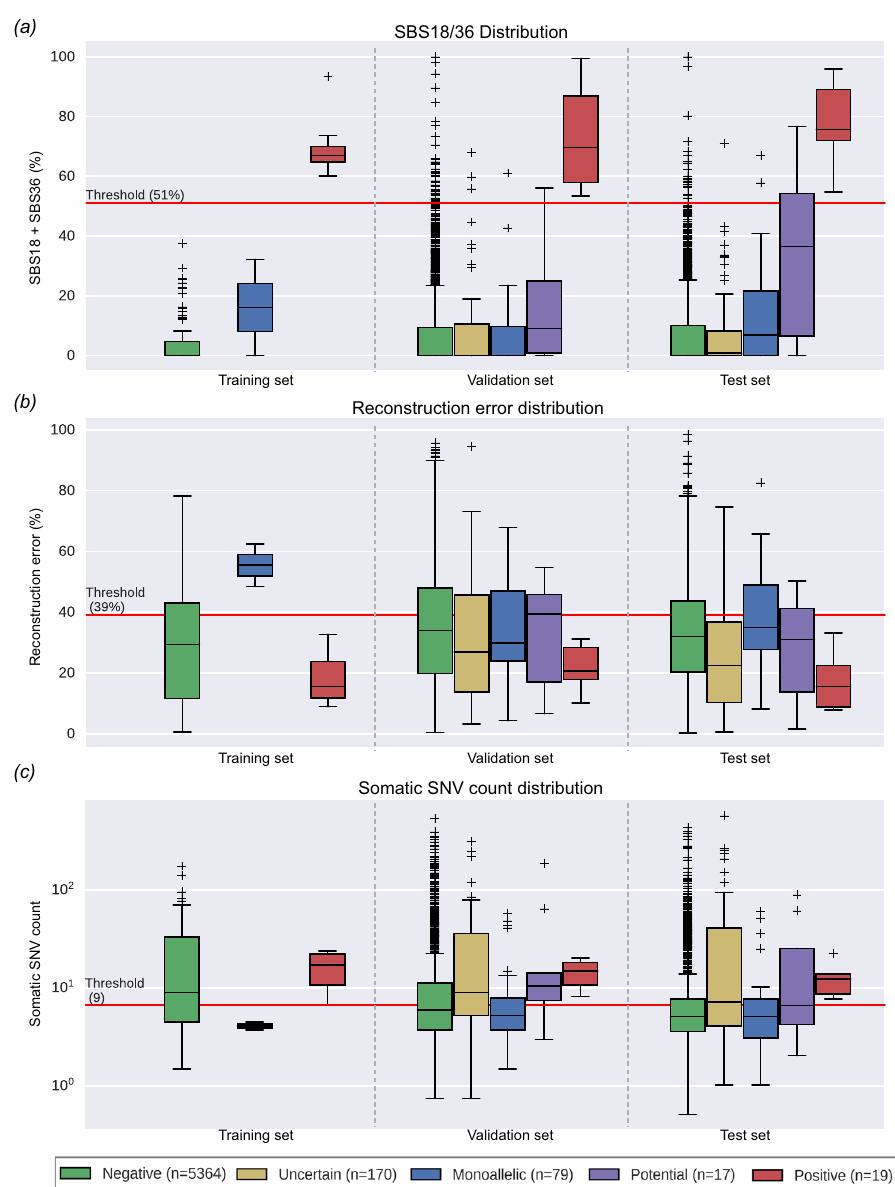
Fig. 3 The distribution of SBS18/SBS36 tumor mutational signature, reconstruction error and somatic single nucleotide variant (SNV) count by the fi ve tumor classi fi cation categories. Distribution of a SBS18/SBS36 tumor mutational signature, b tumor mutational signature reconstruction error, and c adjusted somatic SNV count across 5649 CRCs in the training set, validation set, and test set, grouped by germline pathogenic variant status (tumor classi fi cations). The red horizontal line in each fi gure indicates the cut-offs that were determined based on the training set and validation set tumors. All boxes correspond to the 25th and 75th percentiles and the whiskers represent 1.5× the inter-quartile range (IQR) extending from the boxes. Lines at the middle of each box show the median. Individual observations are shown beyond the whiskers. Source data are provided as a Source Data fi